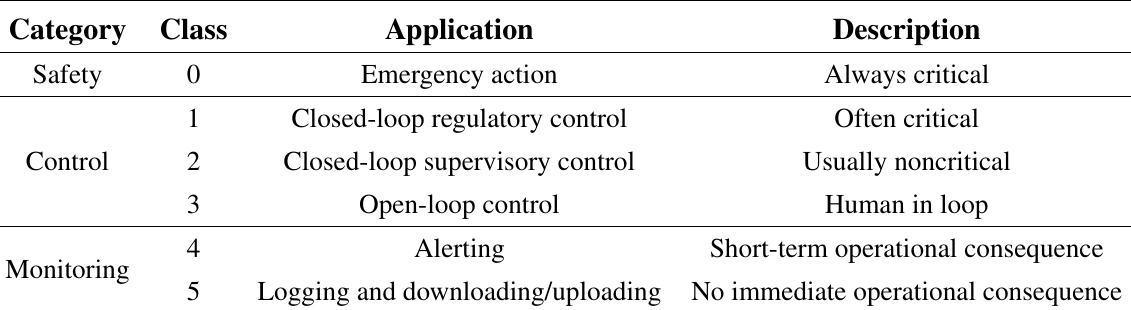
Different classes of applications, as defined by the International Society of Automation